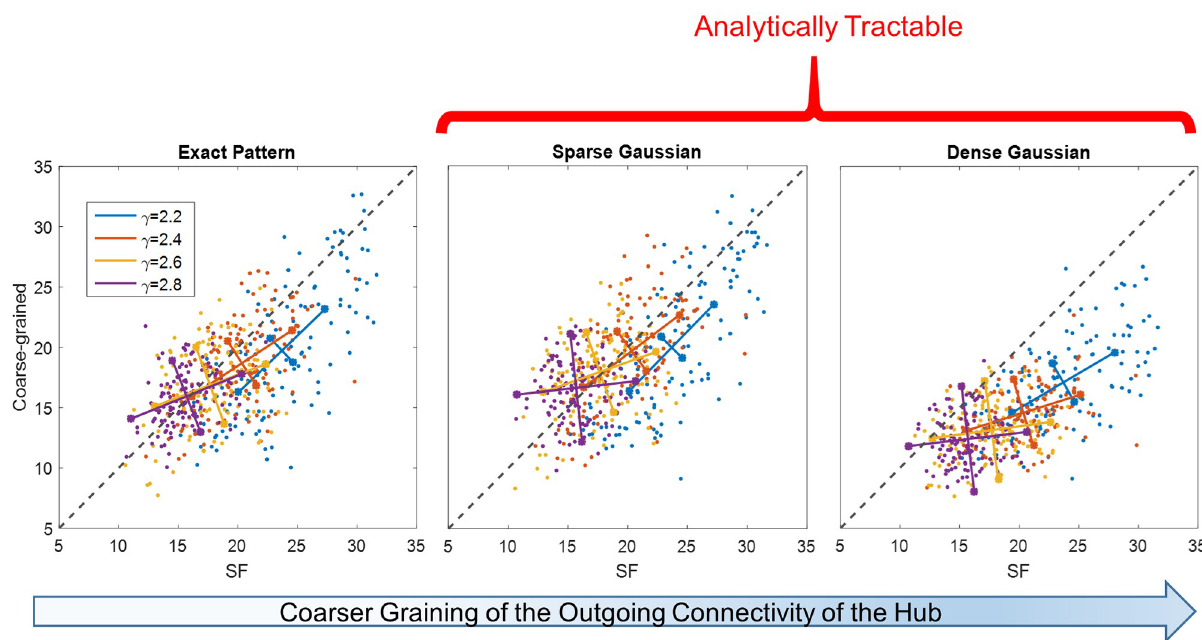
Fig 9. Trajectory dimensionality captured by lumped hub approximation. The participation ratio of trajectories, defined as ð tr C Þ 2 covariance matrix of the trajectories s ( t ), is compared between scale free network and Lumped-hub approximations of increasingly coarser graining. Notations and methods are similar to Fig 4.